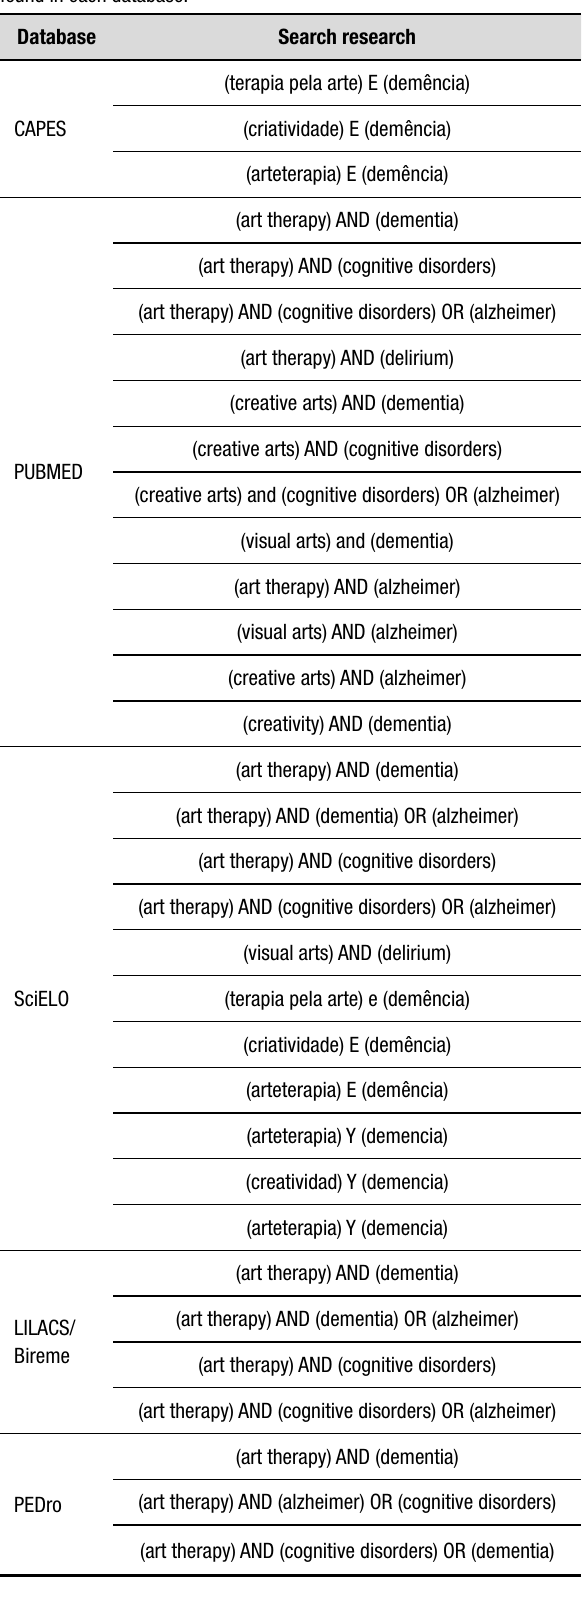
Table 1. Descriptors used in the databases and the number of articles found in each